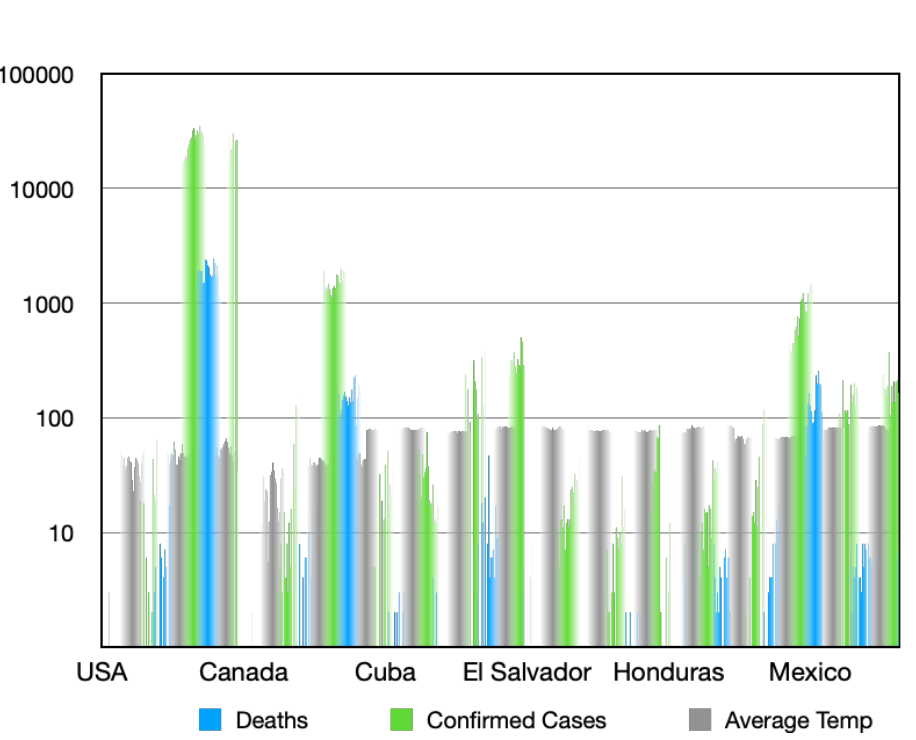
Fig. 5. Drivers of COVID-19 mortality in the North American region.